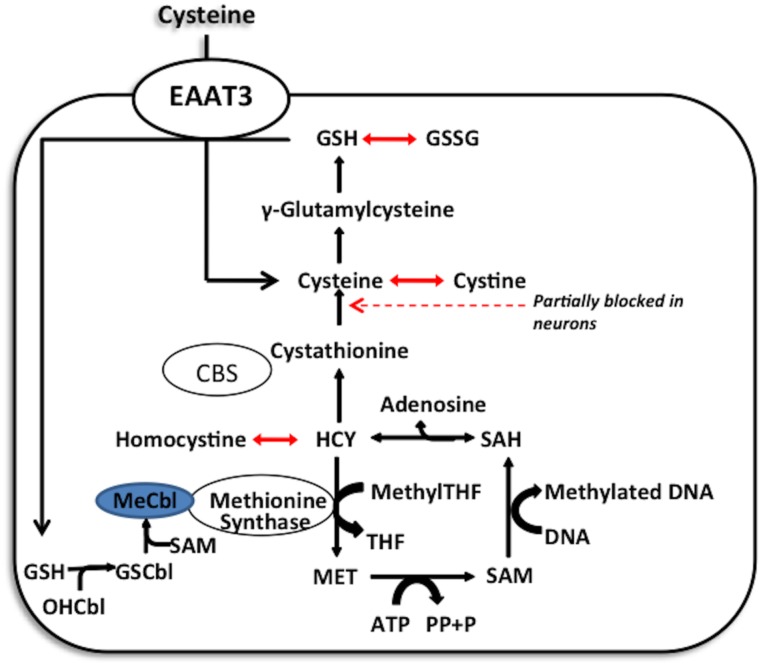
Redox-methylation pathway.Methionine synthase contains a redox-active methylcobalamin cofactor. Under oxidative stress, this cofactor becomes oxidized, limiting methionine synthase activity and can affect the levels of global DNA Methylation Under these conditions, homocysteine can be condensed with serine to form cystathionine and then with cysteine to support GSH synthesis. Another source of the cysteine is through the Excitatory Amino Acid Transport (EAAT3), which is the major source of cysteine especially in the neuronal cells. Cellular redox state is indicated by the GSH/GSSG ratio.